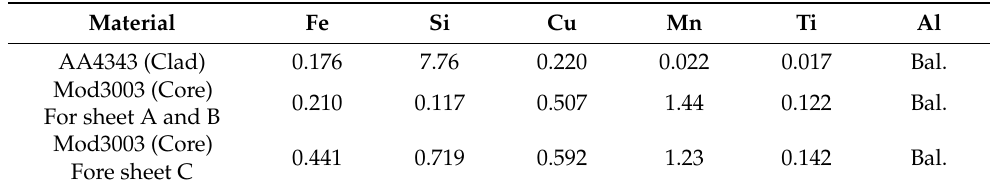
Table 2. Chemical composition (wt. %) of the experimental alloys.